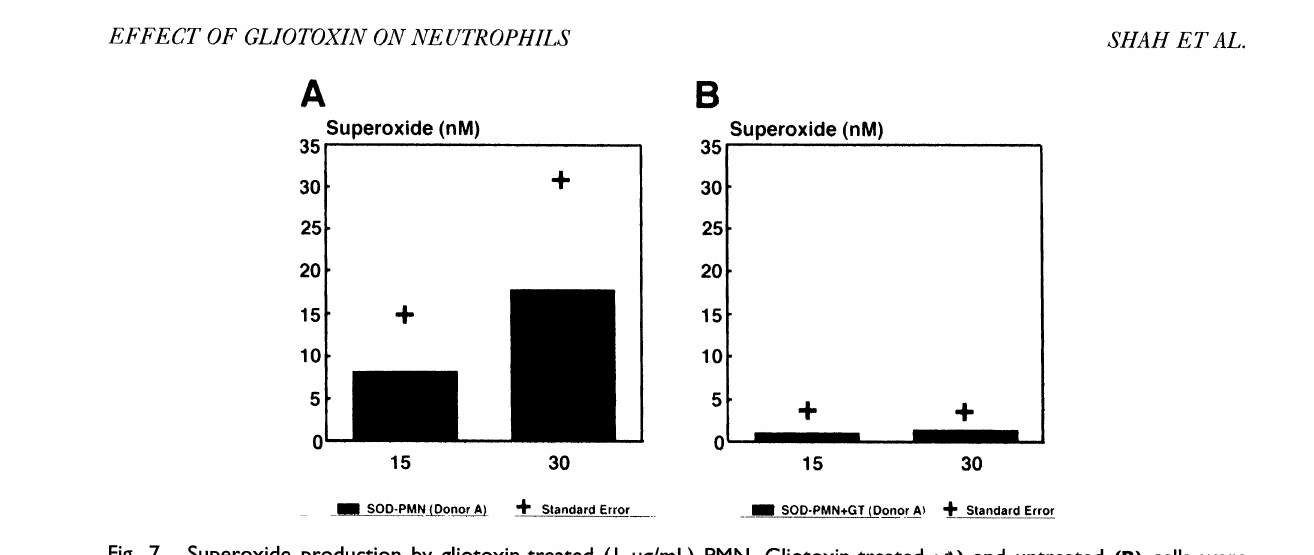
Fig. 7. Superoxide production by gliotoxin-treated (I pg/mL) PMN. Gliotoxin-treated .a.) and untreated (B) cells were stimulated with phorbol myristate. Superoxide was measured spectrophotometrically (570 nm) by cytochrome C reduction in the presence and absence of superoxide dismutase. This study was conducted in triplicate with PMN collected from two healthy human donors.